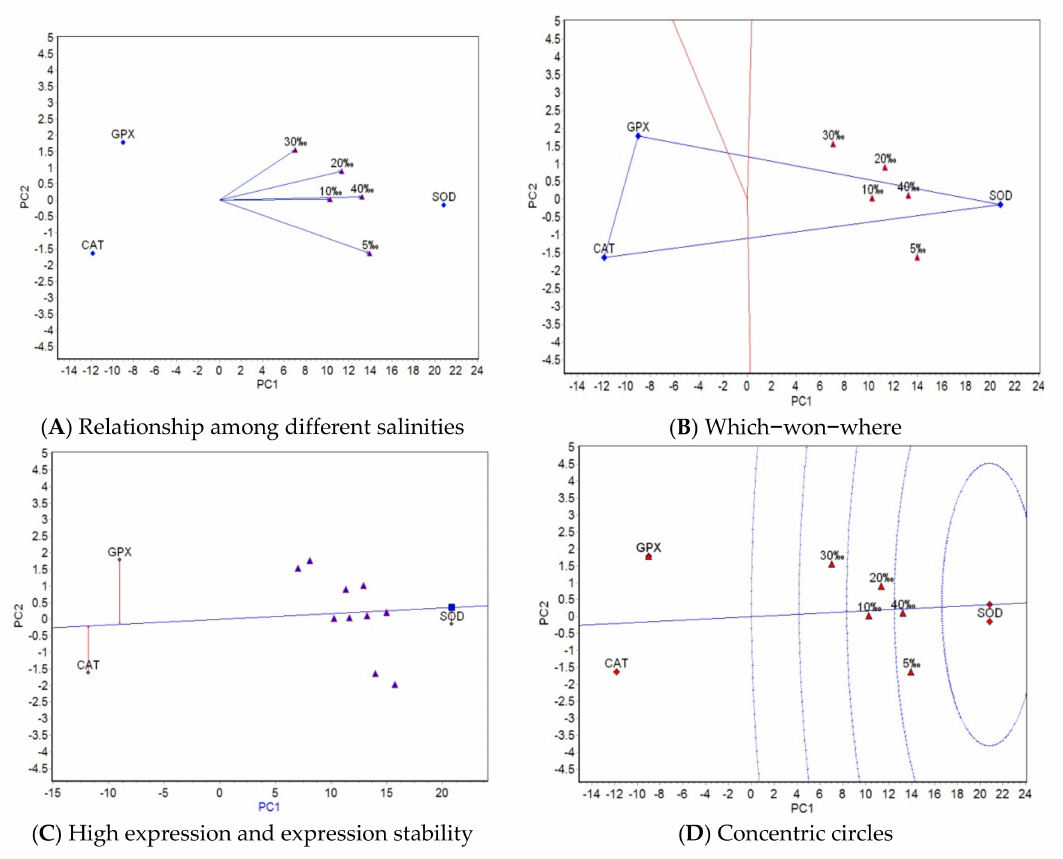
Figure 1. GGE biplots for antioxidant properties in different